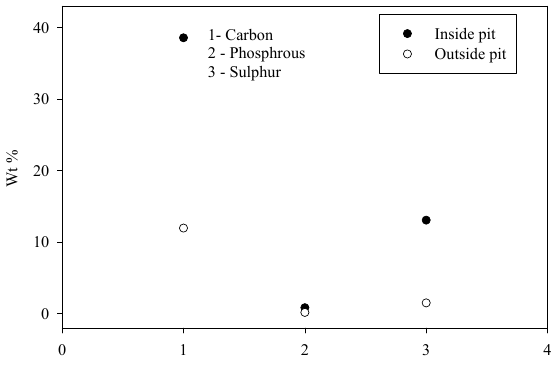
Fig. 14 Weight % of carbon, sulphur and phosphrous detected inside/outside pit formed on corroded stainless steel 304L Figure 14. Weight formed on corroded stainless steel 304L.